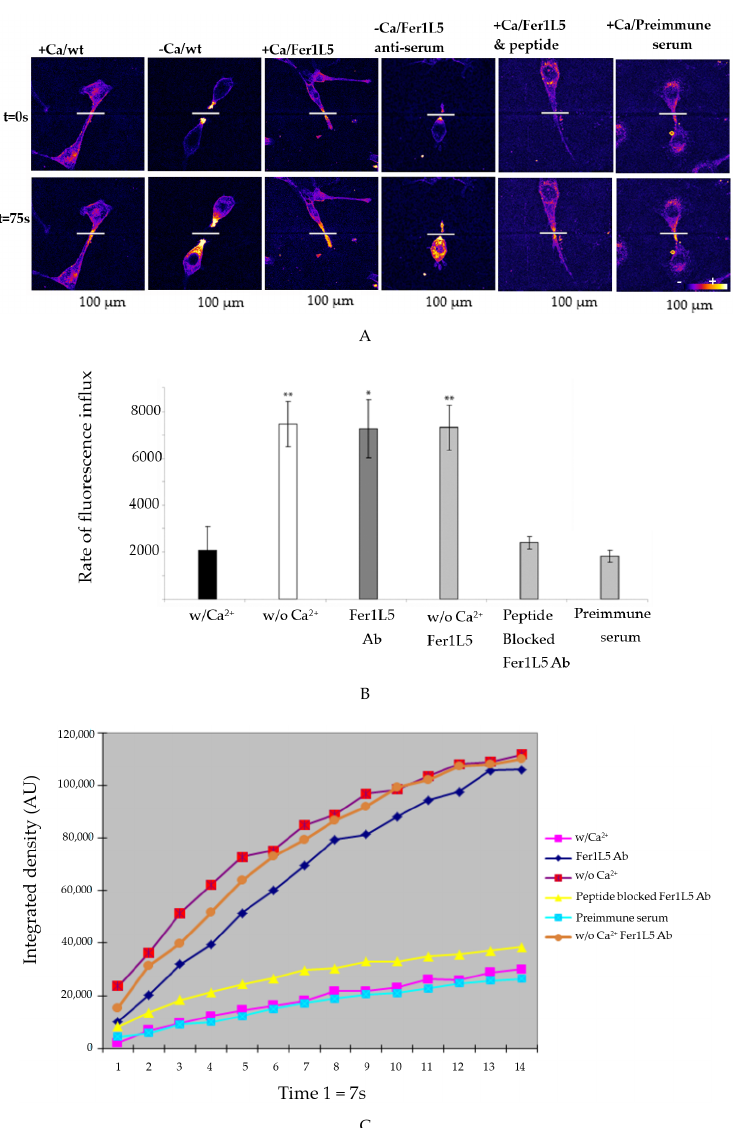
Figure 6. Membrane repair defects in C2C12 myoblasts loaded with Fer1L5 inhibitory antiserum. ( A ) Injury sites in the myoblasts were indicated by white lines. Time is shown in seconds. Scale bar = 100 µm. ( B ) Histogram showing the deduced rates of fluorescence influx ( ∆ (fluorescence) / ∆ t): w / ( n = 3); w / o ( n = 4); Fer1L5 antiserum ( n = 4), w / o Ca 2 + Fer1L5 antibody ( n = 4), peptide blocked Fer1L5 antiserum ( n = 5) and preimmune serum ( n = 3). * indicate a p -value < 0.05; ** p -value < 0.01. (w / ): with calcium. (w / o): without calcium. ( C ) Shows the rate of fluorescence influx every 7 s time duration in the wounded cells with and without Ca 2 + and Fer1L5 antibody as indicated. Controls: Preimmmune serum, peptide blocked Fer1L5 antibody (Ab) and w /